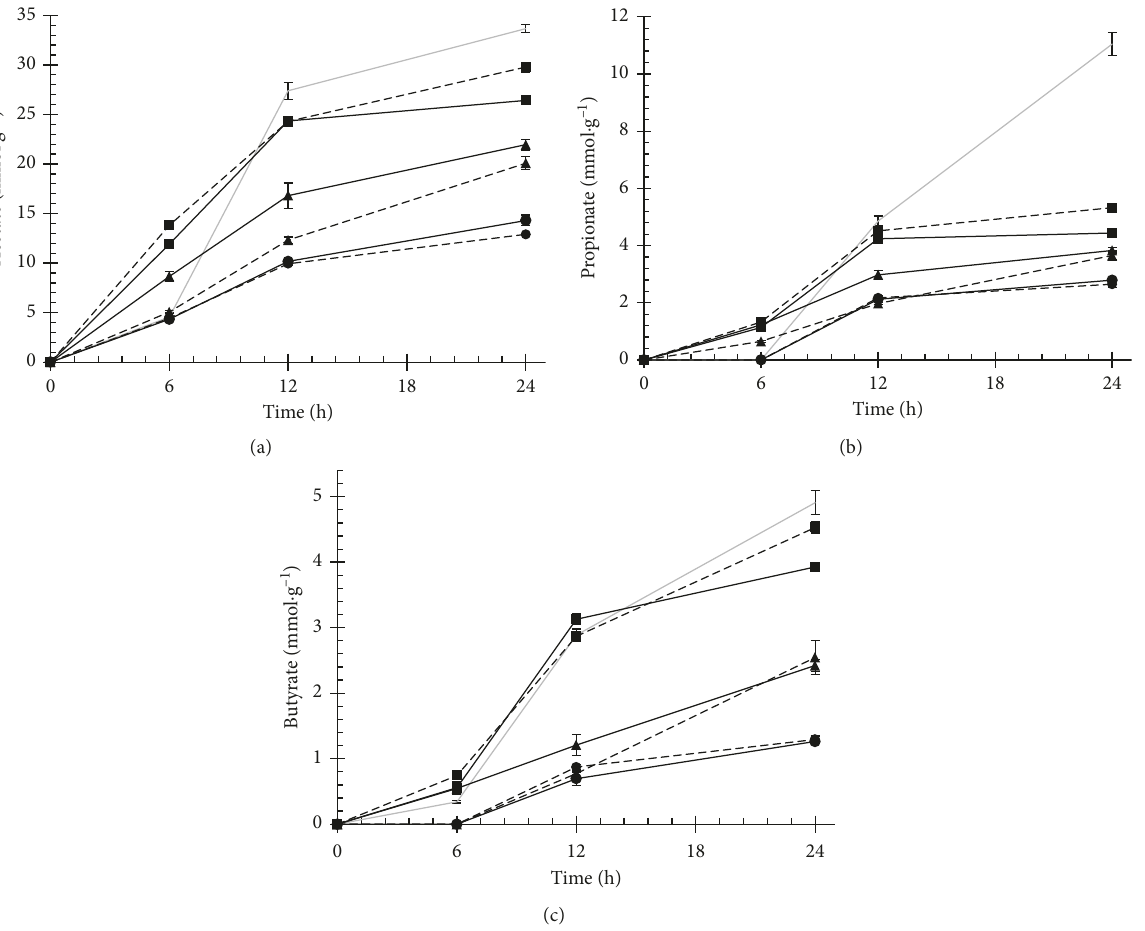
Figure 2: Acetate (a), propionate (b), and butyrate (c) production after 24h of in vitro faecal fermentation of orange ( ), mango ( ), and prickly pear ( ) peel concentrates obtained by freeze-drying ( ) and convective hot air-drying ( ). Fermentation of FOS (grey line) was used as a positive